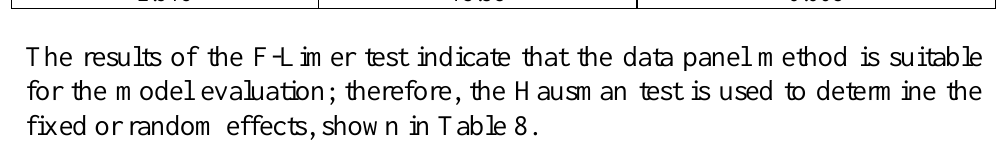
Table 8. Hausman test to determine the fixed or random effects Test statistics